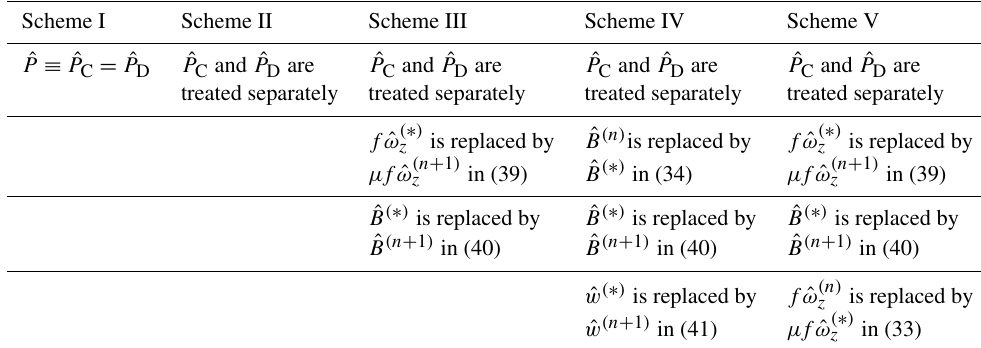
Table 1. A summary of the five schemes that we constructed using the CD grid. Scheme I Scheme II Scheme III Scheme IV Scheme